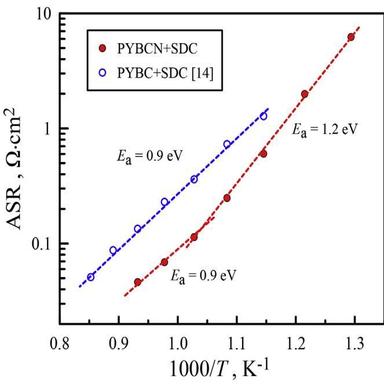
Temperature dependences of ASR for PYBCN/SDC ¼ 70/30 wt% composite cathodes.